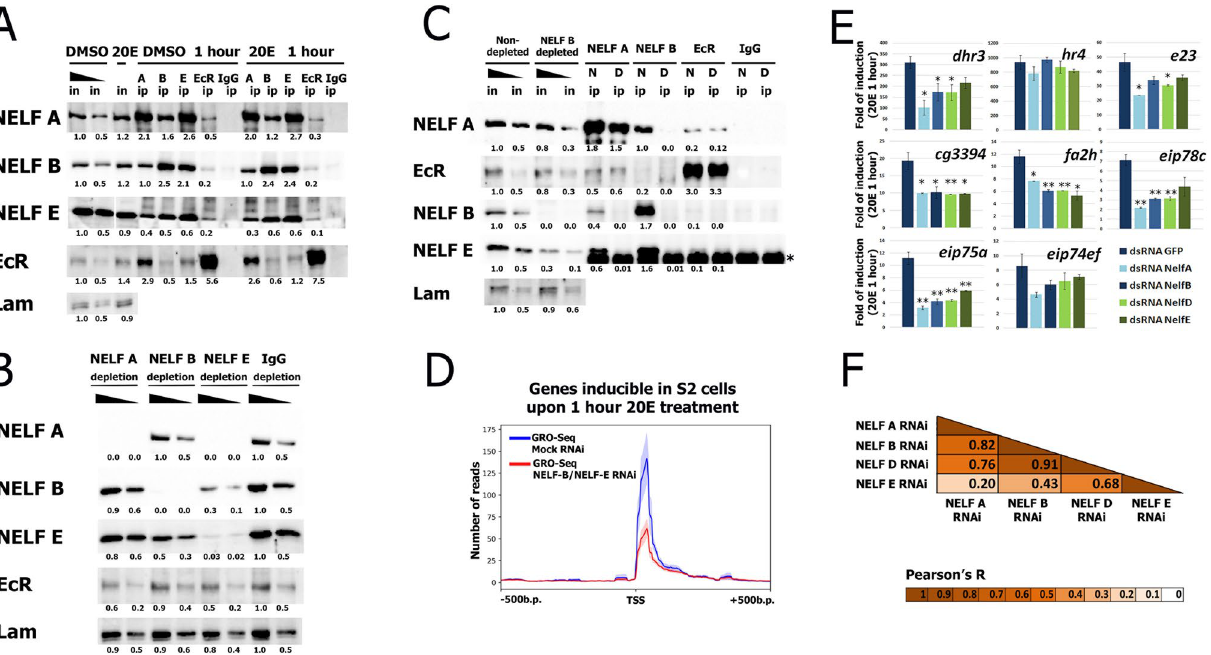
Figure 1. NELF complex interacts with EcR receptor and affects transcription of 20E-dependent genes. ( A ) Immunoprecipitations (IPs) from nuclear protein extracts of 1-h 20E- and DMSO- treated Drosophila S2 cells. Immunoprecipitations were performed with antibodies against NELF-A, NELF-B, NELF-E and EcR (a serum of non-immunized rabbits (IgG ip) was used as a negative control), which is indicated on the top of the figure. Western blots were stained with the corresponding antibodies indicated on the left of the figure. Anti-lamin staining was used as loading control. All input and IP samples were loaded on a single western blot. Western blot stained with anti- NELF-E antibodies included additional titration line between the control and treated cells inputs, which was cut for the uniform presentation of the results. The DMSO-treated input was loaded in the serial loadings (1, 0.5) and used as the calibration for measuring the intensities of the IP lanes in a TotalLab program. The numbers below the IPs represent the portions of precipitated proteins relative to loaded DMSO-treated input. The full-size original Western blots are provided in Fig. S11. ( B ) Depletion of NELF subunits from the protein nuclear extract of uninduced Drosophila S2 cells. Depletions were performed with antibodies against NELF-A, NELF-B and NELF-E (a serum of non-immunized rabbits (IgG) was used as in a negative depletion control), which is indicated on the top of the figure. Western blots were stained with the corresponding antibodies indicated on the left of the figure. Anti-lamin staining was used as loading control. All input and depletion samples were loaded on a single western blot. All the depletions were loaded in the same serial loadings (1, 0.5). IgG depletion was used as the calibration for measuring the intensities of the rest of the depletions in a TotalLab program. The numbers below the depletions represent the portions of loaded proteins relative to loaded IgG depletion. The full-size original Western blots are provided in Fig. S12. ( C ) Immunoprecipitations (IPs) from nuclear protein extracts of uninduced Drosophila S2 cells, with NELF-B depletion (D—depleted) or without it (N—non-depleted). Immunoprecipitations were performed with antibodies against NELF-A, NELF-B, NELF-E and EcR (a serum of non-immunized rabbits (IgG ip) was used as a negative control), which is indicated on the top of the figure. Western blots were stained with the corresponding antibodies indicated on the left of the figure. Anti-lamin staining was used as loading control. All input and IP samples were loaded on a single western blot. The inputs were loaded in the serial loadings (1, 0.5) and the non-depleted input was used as the calibration for measuring the intensities of the NELF-B depleted input and IP lanes in a TotalLab program. The numbers below the NELF-B depleted input and IPs represent the portions of precipitated proteins relative to loaded non-depleted input. The full-size original Western blots are provided in Fig. S13. ( D ) The level of 5 ′ proximal transcription at 20E-dependent promoters in Drosophila S2 cells concomitantly treated with dsRNAs against NELF-B and NELF-E or dsRNA to beta-galactosidase (as mock RNAi) was estimated by GRO-Seq (the GRO-Seq data were taken from GSM3274627 and GSM3274628 (described for the first time in ref. 29 ) and the list of 20E-dependent genes from our previous study 1 ). Pile-up profiles were calculated as a mean of a GRO-Seq signal. The Y-axis units represent number of reads. The standard error is displayed on the graphs as lighter area around the main line of the profile. ( E ) Transcriptional induction levels of 20E-dependent genes in 1-h 20E-induced Drosophila S2 cells relative to DMSO-treated. The impact of NELF-A, NELF-B, NELF-D and NELF-E subunits of NELF complex on 20E response was estimated using RNA interference-mediated knockdown with corresponding dsRNA (GFP dsRNA was taken as a mock RNAi). Transcriptional levels were assessed by qRT-PCR. The Y-axis units represent fold of transcription induction which was calculated as a ratio between transcriptional level of corresponding gene in a particular experiment and mock RNAi treated uninduced cells sample (and normalized on tubulin mRNA). The data are mean values from three independent experiments, error bars represent standard deviations. Asterisks indicate significance levels (Student’s t-test), **— p -value < 0.01, *— p -value < 0.05. Statistical analysis was performed relative to the transcriptional induction levels of the genes in GFP dsRNA treated S2 cells. ( F ) Pearson’s correlation matrix for the impact of NELF-A, NELF-B, NELF-D and NELF-E subunits knockdowns on transcriptional induction levels of 20E-dependent genes in 1-h 20E-induced Drosophila S2 cells relative to DMSO-treated (the list of the genes is the same as on E ). The heat map reflects the indicated R